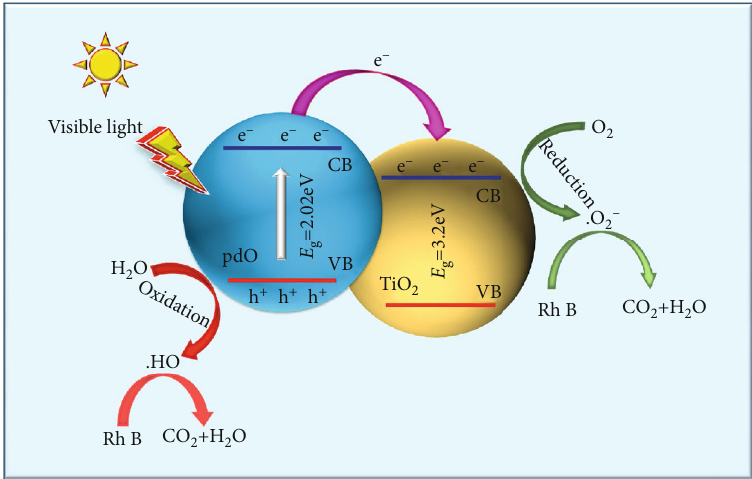
Figure 8: Photocatalytic mechanism of TiO